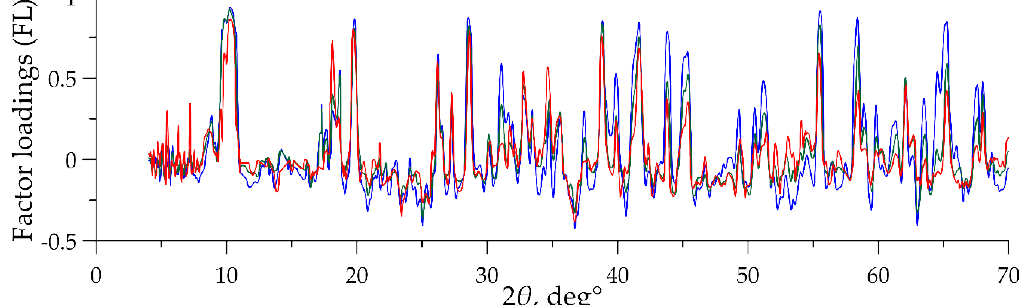
Figure 8. Comparison of the FL graphs of three analogous factors obtained by processing the XRPD datasets of the entire set of rocks (green line), the set of carbonatites sensu stricto (blue line), and the cumulative set of silicocarbonatites and carbonate-bearing silicate rocks of Kontozero (red line).